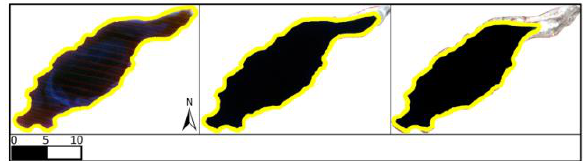
Figure 3 . Burdur Lake areas and shorelines (yellow polygons) for the years 1998, 2008 and 2018, respectively, from left to right.